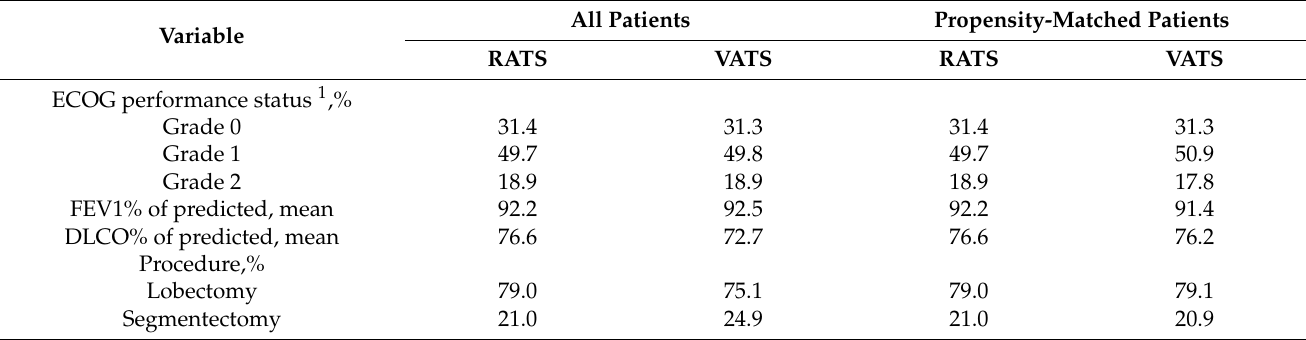
Table 2. Matching characteristics of the